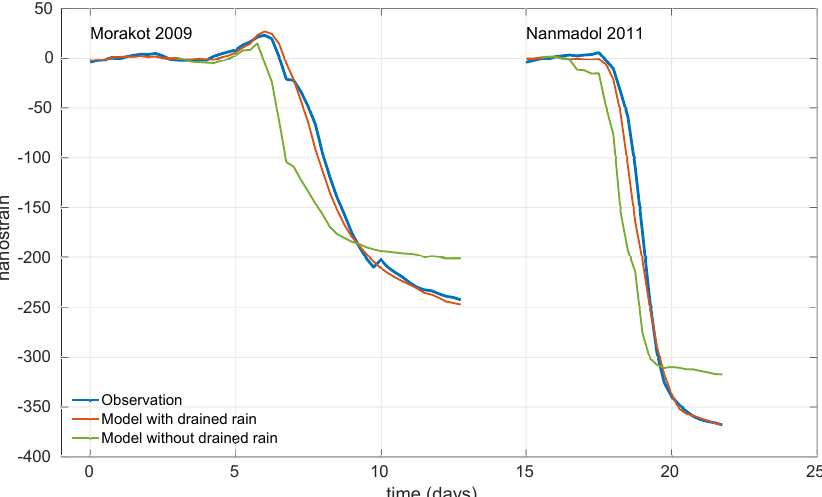
Figure 17. Strain variations measured during typhoons Morakot in 2009 and Nanmadol in 2011, at site TRKB (blue curve). This figure shows the necessity to account for the load created by rainwater drained from watershed in addition to the rainwater falling directly nearby the strainmeter. The strain computed in that case (red curve) explains the strain observations better than the strain computed only from the accumulated precipitation on the ground above the sensor (green